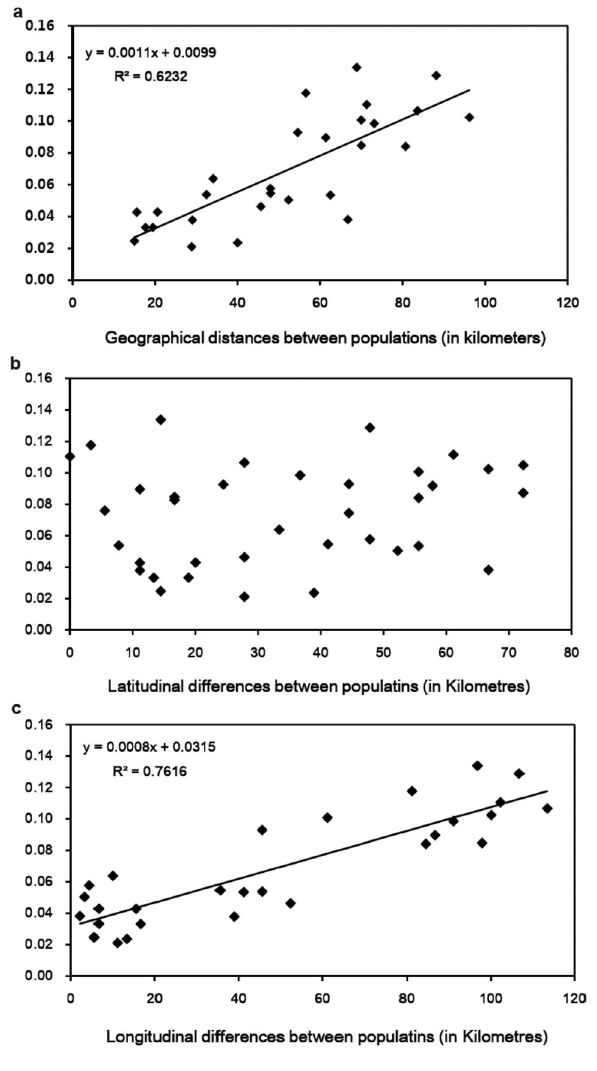
Figure 2. Mantel tests between the genetic distance and the geographical parameters. (a) Mantel test between Nei’s genetic distance and the geographical distance among populations. (b) Mantel test between Nei’s genetic distance and the latitudinal distance. (c) Mantel test between Nei’s genetic distance and the longitudinal distance. In 2a, 2b, and 2c, the X- axis represents the geographical parameter, and the Y-axis represents Nei’s genetic distances between the populations.